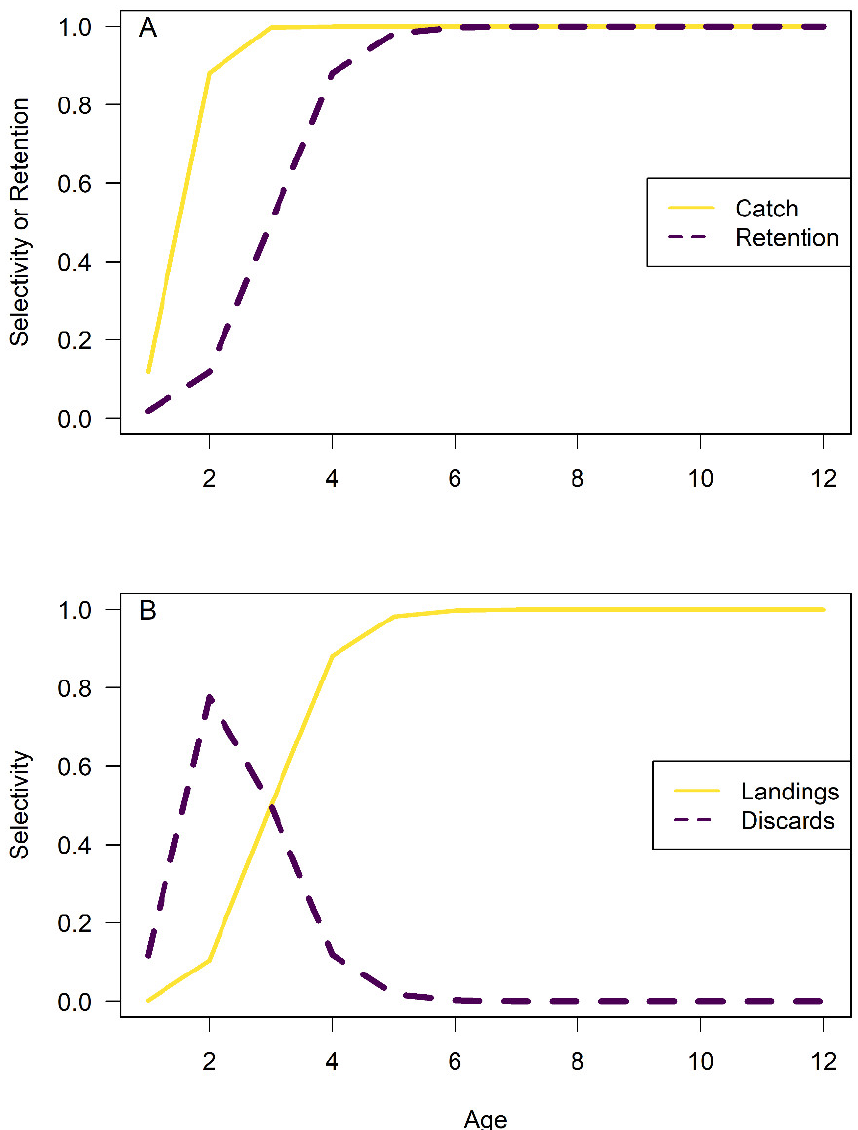
Figure 1. Selectivity curves used in simulations, based on parameter values shown in Table 1 for Simulation 1. ( A ) Selectivity of the catch (yellow, solid) and the retention function (purple, dashed). ( B ) Resulting selectivity of landings (yellow, solid) and of discards (purple, dashed). The base model estimated total discards based on the selectivity and retention func- tions, then calculated (and fit) dead discards (in numbers) based on the release mortality rate. Fleet-specific release mortality rates were treated as fixed model inputs for the com- mercial vertical line (19%), the commercial longline (41.5%), the commercial trap (10%), and the recreational fleet (11.6%). Dead discards were fitted assuming a lognormal error structure and a CV of 29% (derived from expert opinion) for each fishing